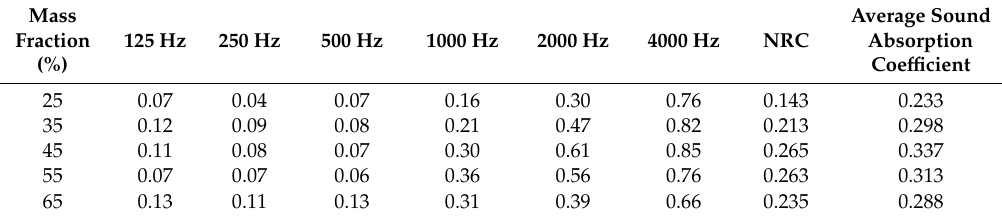
Table 1. Noise reduction coe ffi cient (NRC) and average sound absorption coe ffi cient of composite materials that were prepared with di ff erent mass